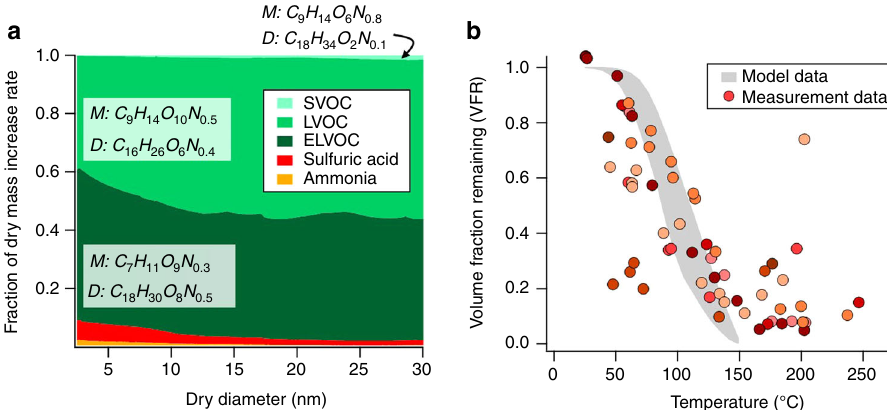
Fig. 4 Particle-phase composition and volatility. a Modeled average contribution (all new particle formation (NPF) events) of 17 volatility bins lumped to semi-volatile organic compounds (SVOC), low volatility organic compounds (LVOC), and extremely low volatility organic compounds (ELVOC) to dry particle mass increase as a function of particle size with mass-weighted mean molecular formulae for compounds with <11 carbon atoms ( “ monomers ” , M) and >10 carbon atoms ( “ dimers ” , D). b Volume fraction remaining (VFR) of particles with diameter 30 nm measured by a thermodenuder (TD) for all NPF events (circles). The different colors represent different NPF days. Shaded area: modeled VFR curve using the particle volatility distribution as given by the output of the Model for Acid – Base Chemistry in Nanoparticle Growth (MABNAG), all NPF